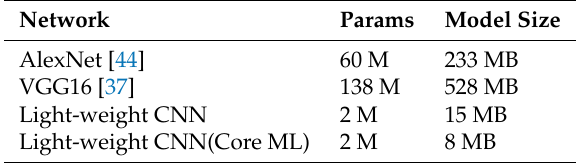
Table 6. Number of parameters and model size of different